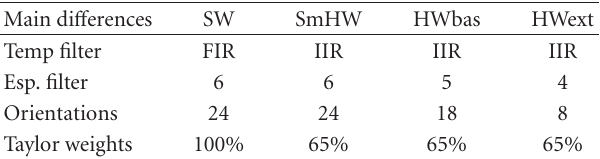
Table 2: Summary of the di ff erent